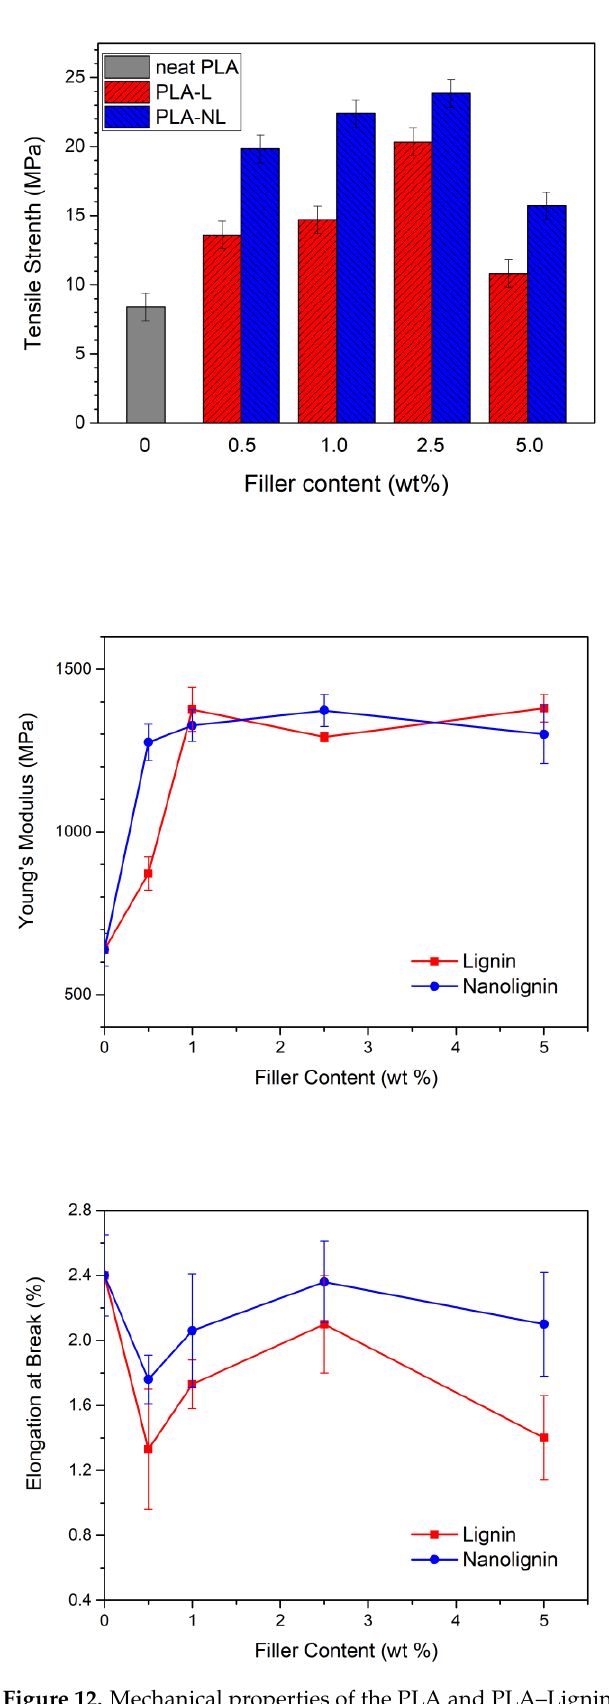
Figure 12. Mechanical properties of the PLA and PLA–Lignin/Nanolignin composites .